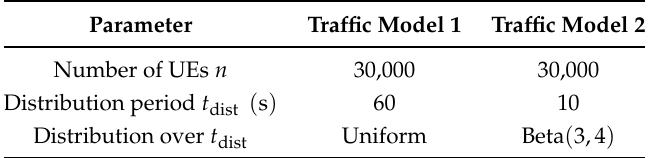
Table 1. Characteristics of the different traffic models defined by the 3GPP for the performance evaluation of the RAP